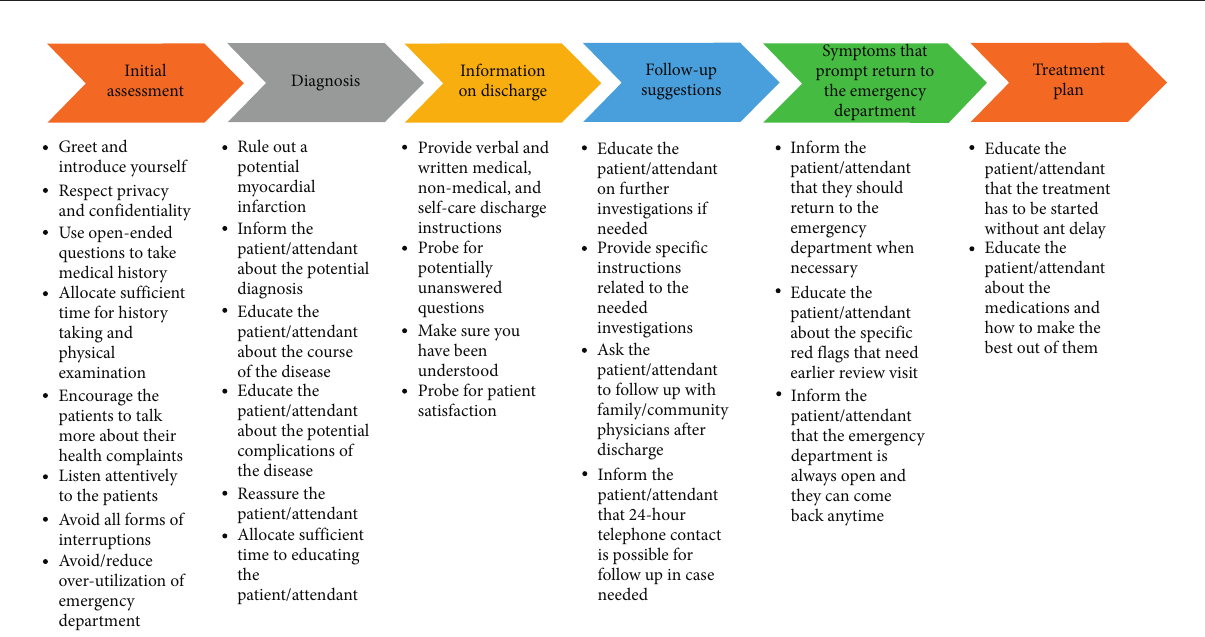
Figure 5: The most important key messages that can be used in guiding discharge communication.